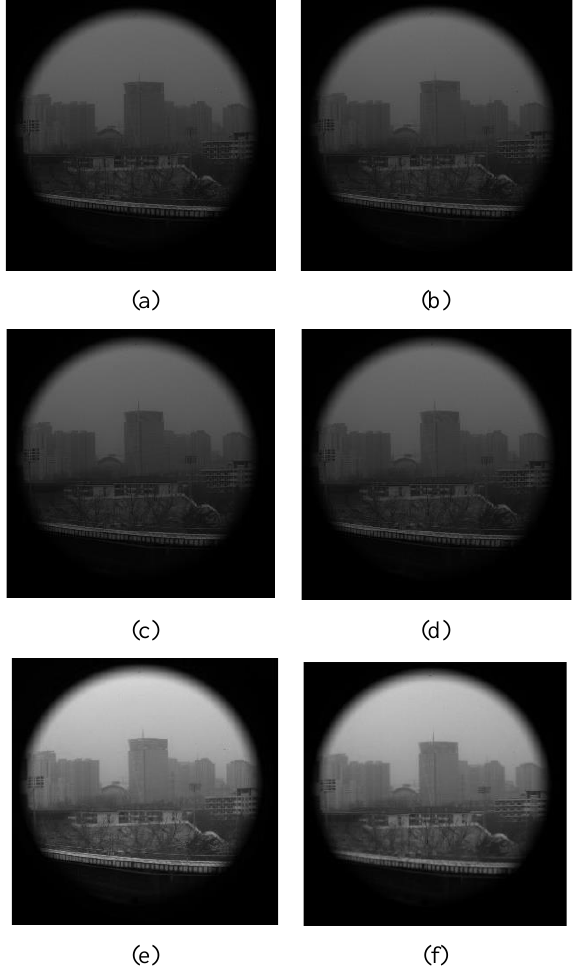
Figure 2. Estimation of maximum- and minimum-intensity images. (a), (b), (c) and (d) four different original haze polarization images in 530nm, (e) maximum-intensity image, (f) minimum-intensity